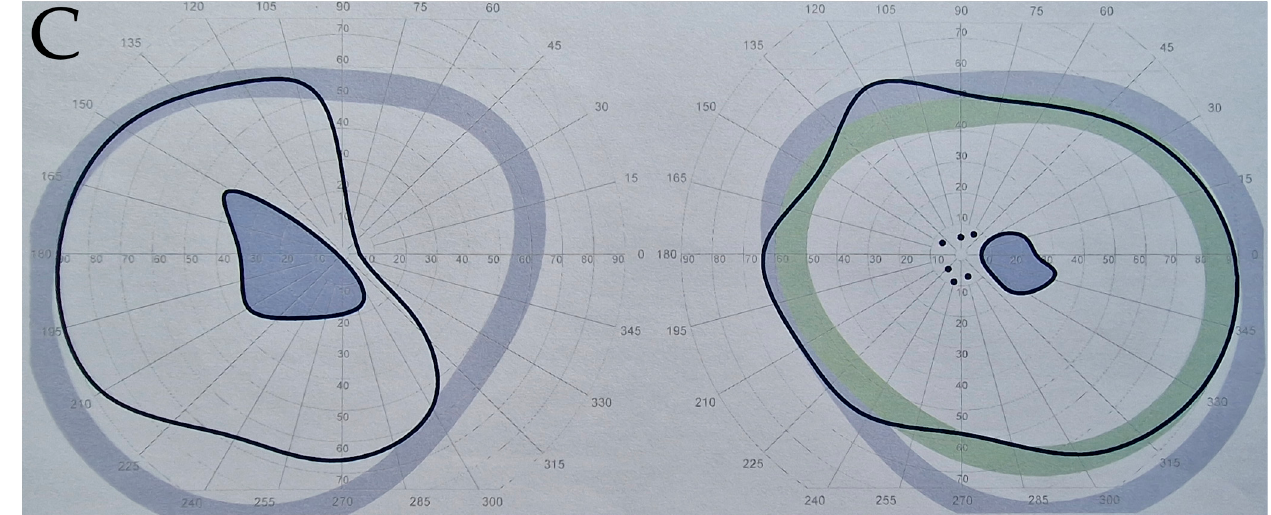
Figure 2. Visual field testing results showing representative classifications, with right visual field on right side and left visual field on left side of figure, I2e target in red, I4e target in green, V4e target in blue. Normal visual field bilaterally in E1 with substantially preserved I2e ( A ), mildly reduced vision field in right eye with central reduced sensitivity of I2e isopter, with moderate visual field scotomata in left eye in U15 with loss of I2e target ( B ), and bilateral severely reduced visual field with only V4e target seen in C8 ( C ).